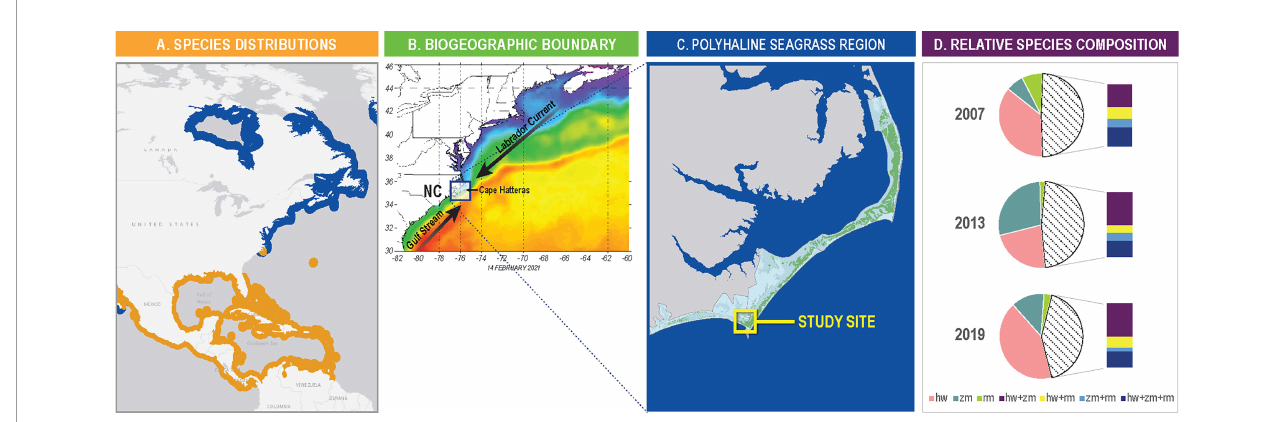
FIGURE 1 | (A) Species distribution of Zostera marina (blue) and Halodule wrightii (orange) in the Western North Atlantic Ocean (distribution data from IUCN). The distribution of Ruppia maritima is cosmopolitan and overlaps with both Z. marina and H. wrightii . (B) Example of ocean temperature conditions highlighting the intersection of the Gulf Stream and the Labrador Current off Cape Hatteras NC that establish biogeographic boundary conditions. Data was collected in February 2021. Red and orange represent warmer water temperature and purple and blue cooler water temperatures. (C) Known historical extent of seagrass throughout the polyhaline region of the Albemarle Pamlico Estuarine System in coastal North Carolina from a composite of mapping efforts spanning 1981-2019 (data from NC Division of Marine Fisheries). (D) Relative seagrass species contribution in 2007, 2013 and 2019 throughout entire NC polyhaline seagrass region. Data are shown as percent observations as single species H. wrightii (orange), Z. marina (red), Ruppia maritima (green), or mixed meadow combinations (stippled). For multiple species combinations HW+ZM is in purple, HW+RM is in yellow, ZM + RM is light blue and all three are shown as dark blue (data from NC Division of Marine